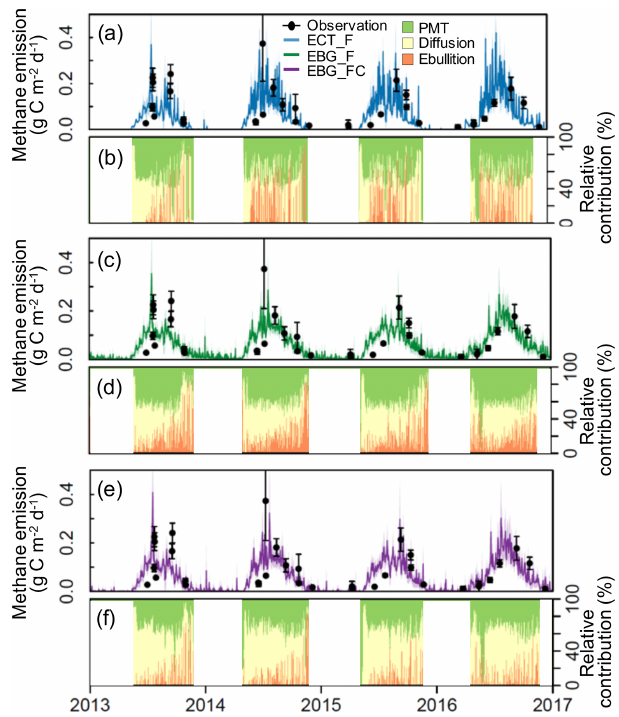
Figure 3. Observed versus modeled methane emissions ( a , c , and e ) and simulated relative contributions (%) of plant-mediated trans- portation (PMT), diffusion, and ebullition under ambient condi- tions ( b , d , and f ). Black dots are observed CH 4 emissions from static chamber measurements. Error bars are the standard errors. Blue lines are ECT-model-simulated CH 4 emissions based on the parameter probability distributions (PPDs) constrained by CH 4 flux data (ECT_F, RMSE = 0.61). Green lines are EBG-model- simulated CH 4 emissions based on the PPDs constrained by CH 4 flux data (EBG_F, RMSE = 0.53). Purple lines are EBG-model- simulated emissions based on the PPDs constrained by both CH 4 flux and concentration data (EBG_FC, RMSE = 0.52). The mid- lines and shaded areas correspond to the means and standard de- viations, respectively, from 500 model simulations with parameters randomly drawn from the posterior distributions. Relative contribu- tions (%) are the daily mean values calculated from the